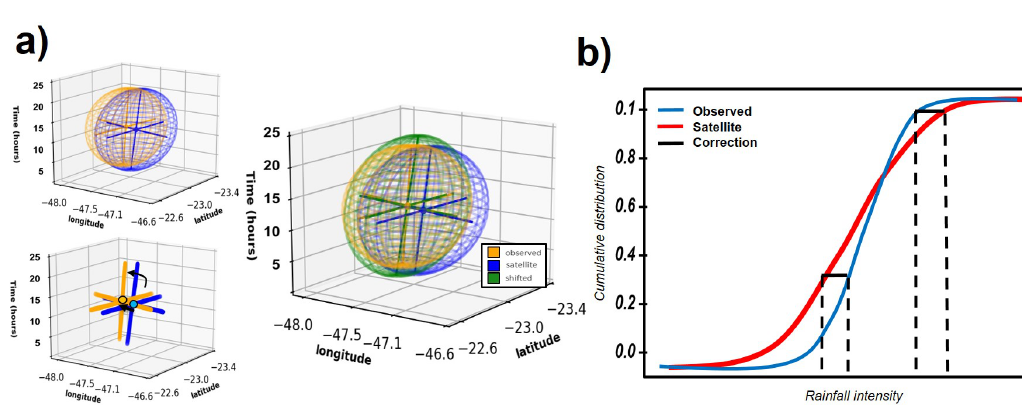
Figure 4. ST-CORAbico systematic error subtraction. ( a ) In error correction, storm centroid and eigenvectors derived from principal component of GPM-IMERG are fitted to the observed event; and, ( b ) magnitude subtraction using both satellite and observed empirical distribution functions, with respect to